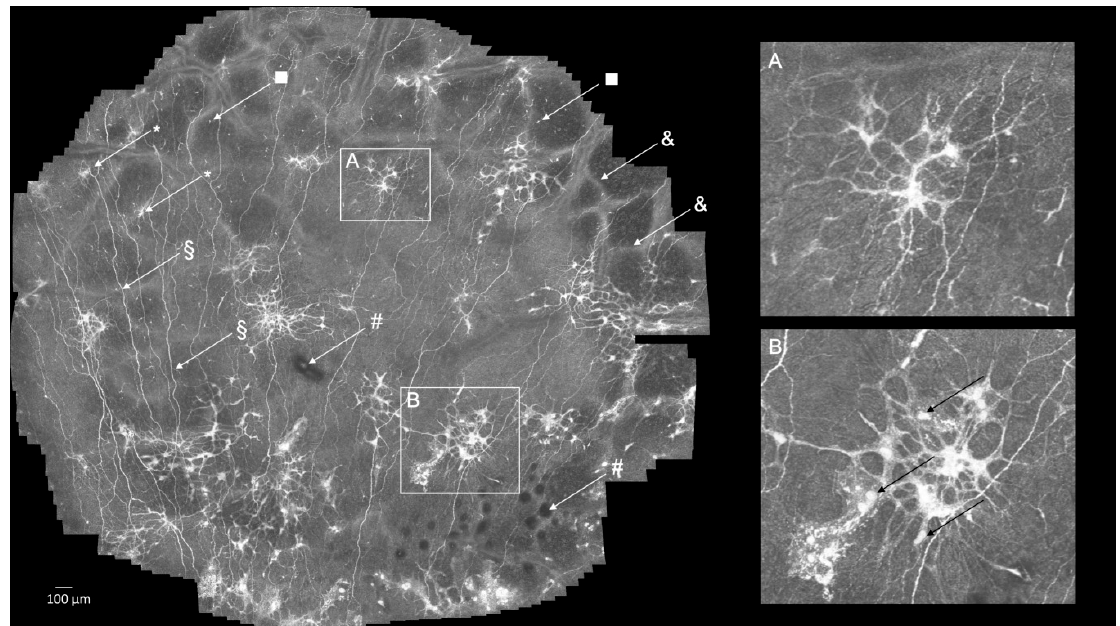
Figure 2. Subbasal nerve plexus (SNP) in the cornea of a 71-year-old male admitted to hospital due to hyperglycemia. Clusters of hyperintense, large, cellular-like structures are present throughout the central cornea (§, nerves of the SNP; &, applanation artifacts; #, hypointense areas of unknown origin; *, neuroma; and (cid:3) , dendritic cell) (high-resolution image supplementary Figure S2). Inset ( A ): the cellular-like structures are stellate-shaped and appear to possess multiple cytoplasmic processes, and inset ( B ): hyperintense cellular structures with enclosed “granular-like” accumulations which could represent cell nuclei (black arrow).